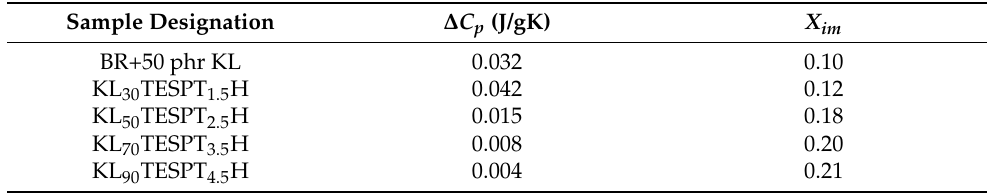
Table 5. Parameters obtained from DSC